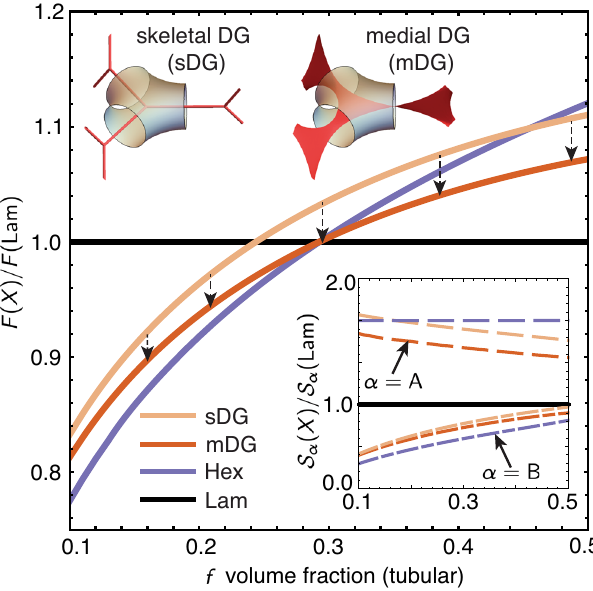
Fig. 3 Medial versus skeletal chain packing thermodynamics. Free energy comparison of medial-DG (mDG) and skeletal-DG (sDG) to competitor hexagonal cylinder (Hex) and lamellar (Lam) phases, for conformationally symmetric linear diblocks. Inset shows scaled entropic cost of stretching for both blocks (compared at equal IMDS area per chain).